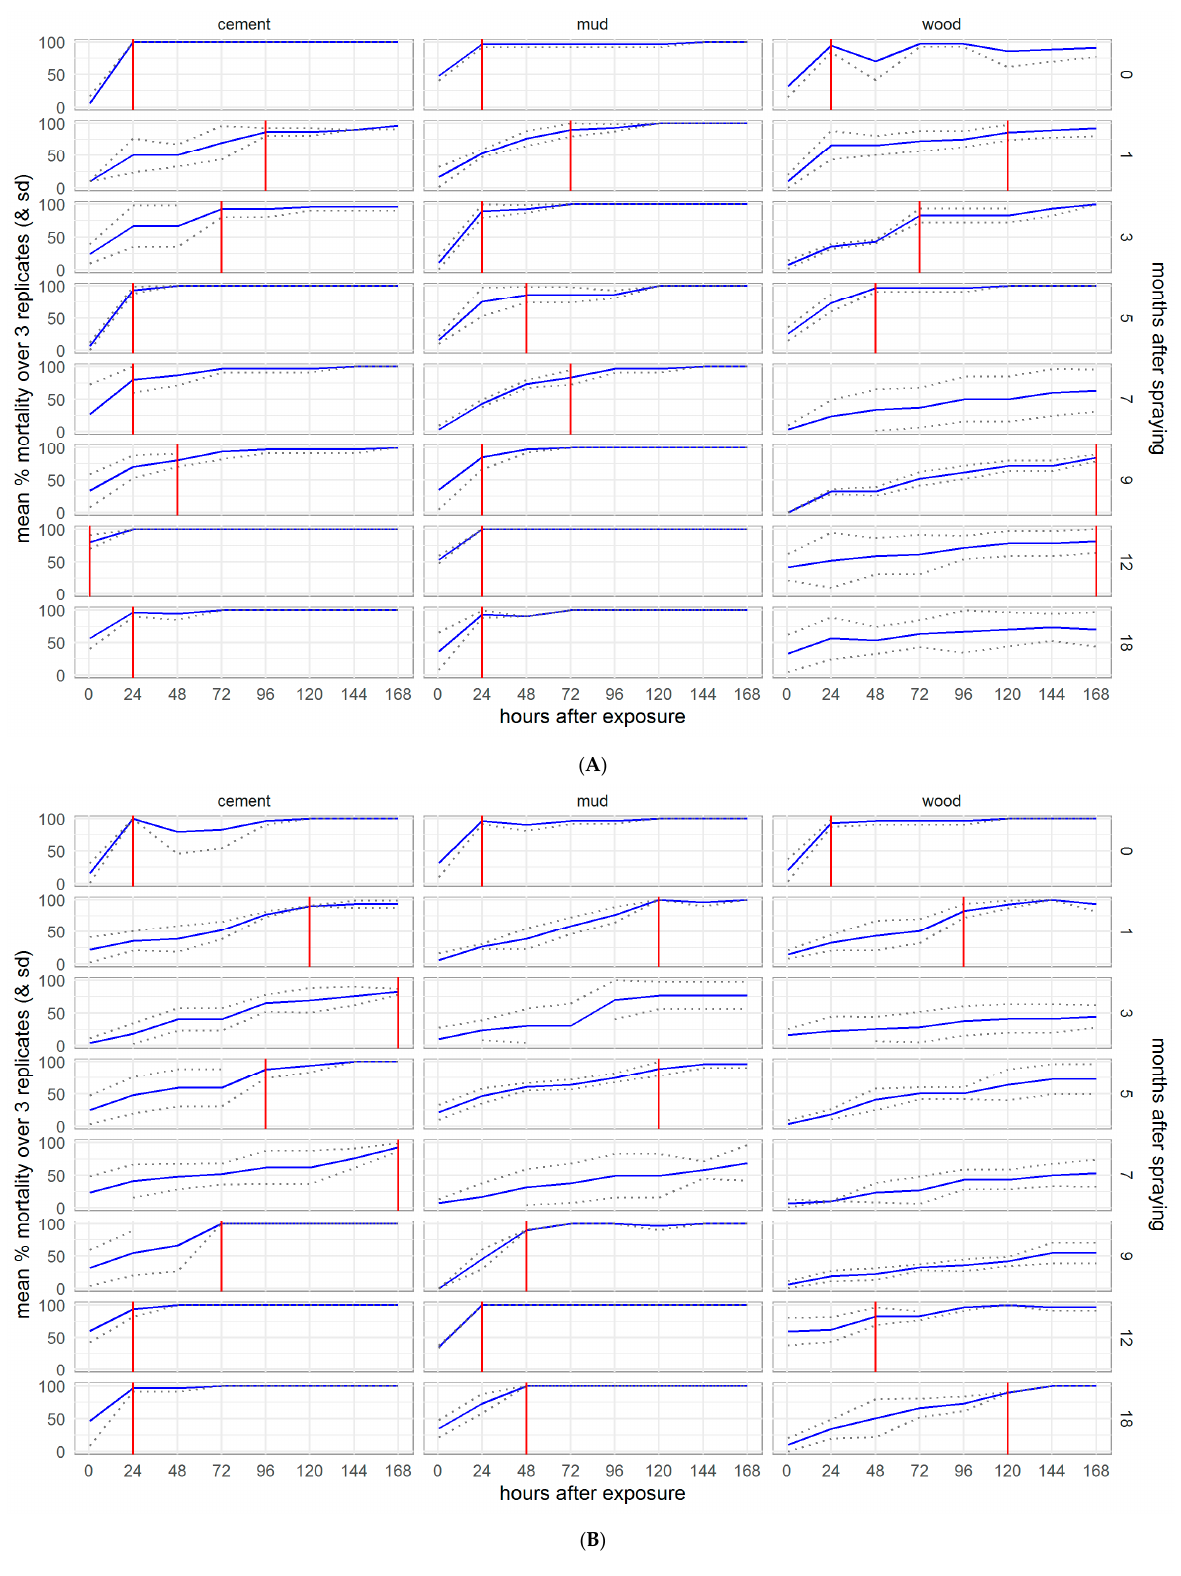
Figure 6. Speed of action of SumiShield TM 50WG against insecticide susceptible ( A ) and resistant ( B ) strains of Anopheles funestus . Cumulative mortality is shown by hours post-exposure to treated cement, mud, and wood surfaces, for each month of the experiment. The time to reach the WHO recommended 80% mortality threshold for an IRS product is marked with a red